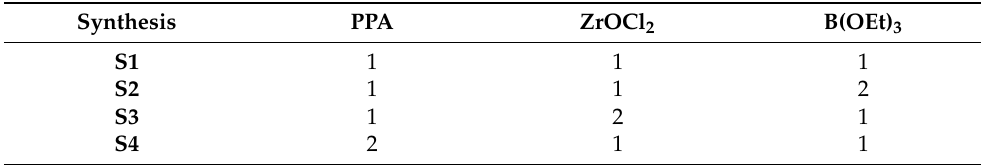
Table 1. Molar ratios of the reagents used for obtaining hybrid compounds S1 – S4 .